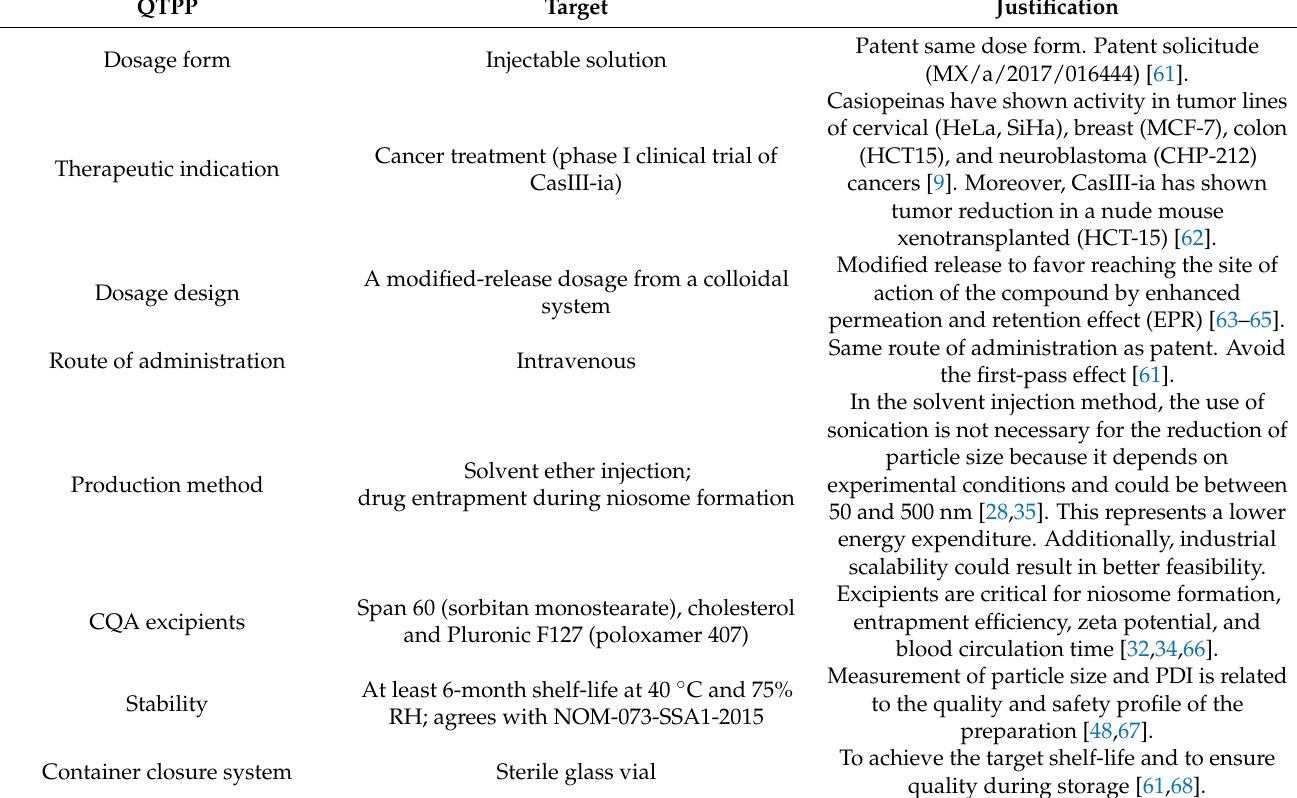
Table 5. Quality target product profile for CasIII-ia nanoformulation.